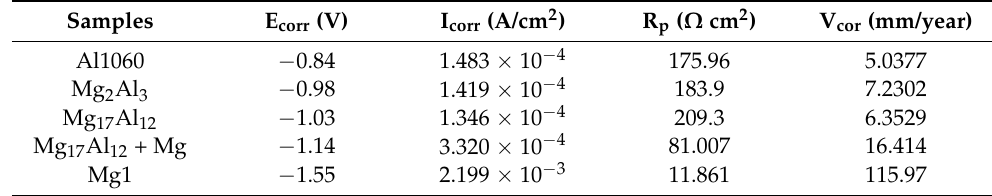
Figure 7. Electrochemical polarization curves of the substrates and different diffusion layers in a 3.5 wt.% NaCl solution. Table 4. Polarization data of Al1060, Mg1, and diffusion layers in 3.5 wt.% NaCl